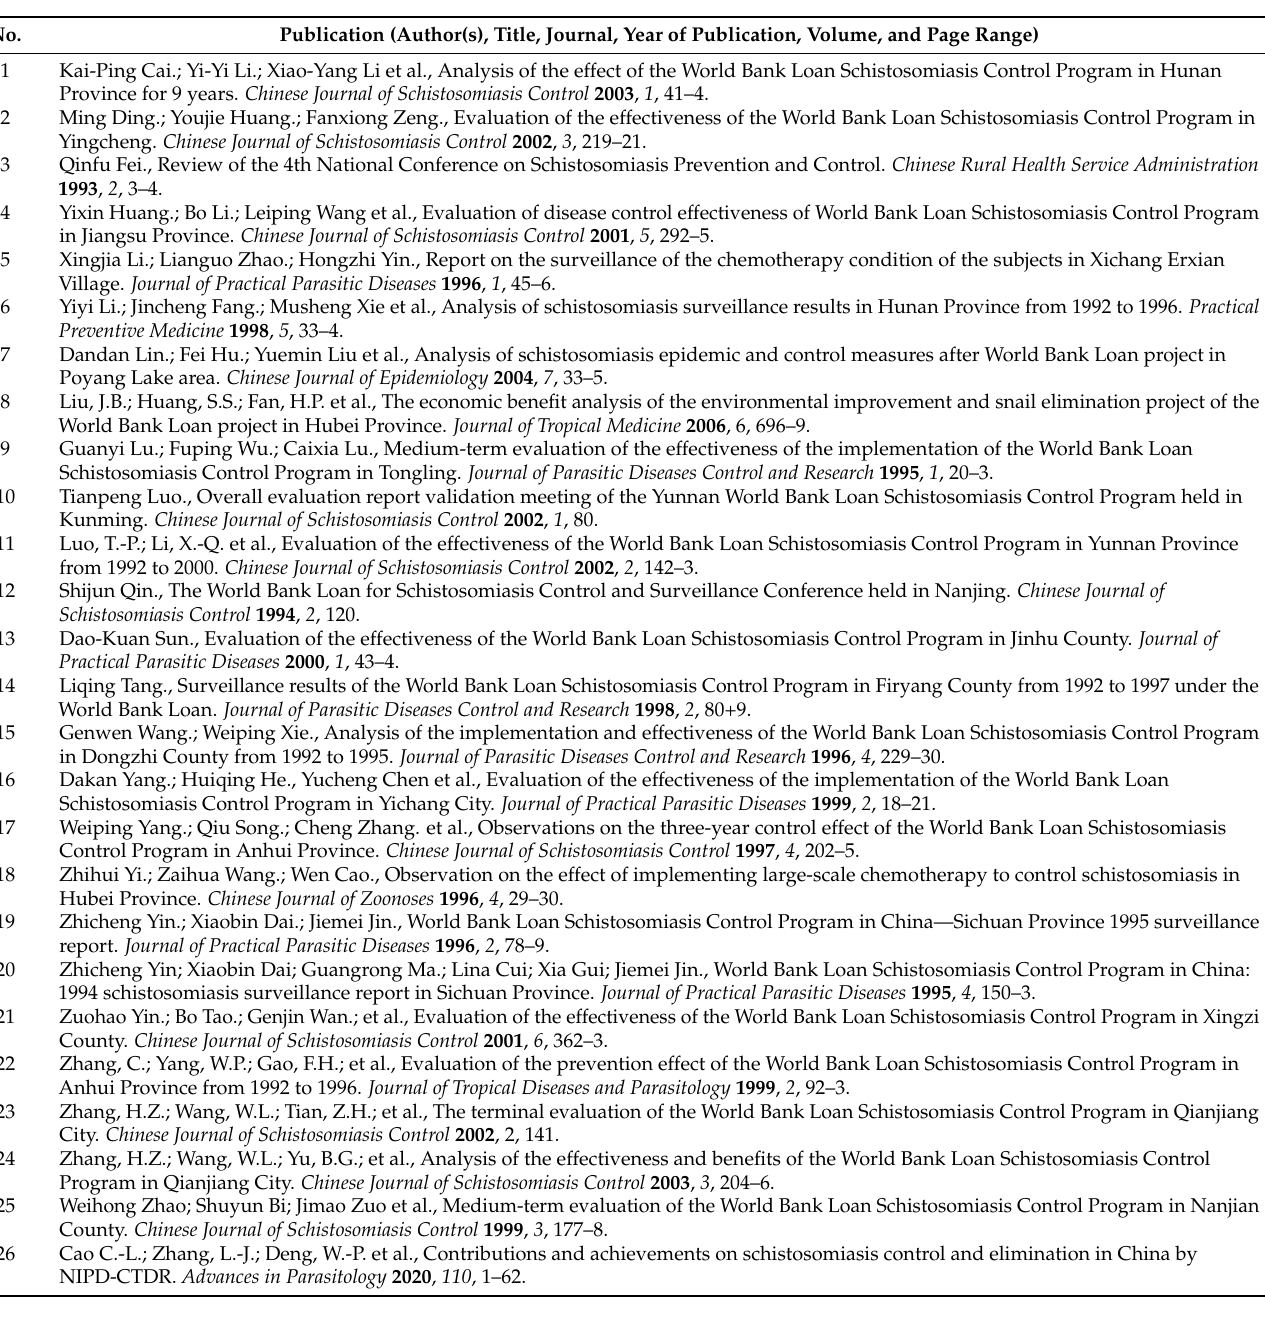
Table A1. Summary of the literature review on long-term effectiveness of the